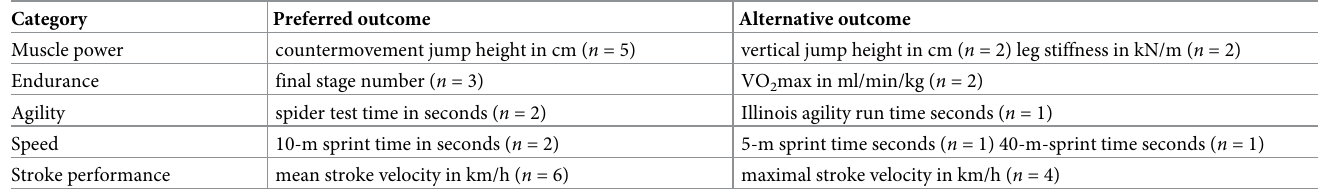
Table 2. Overview of the preferred and alternative outcome by